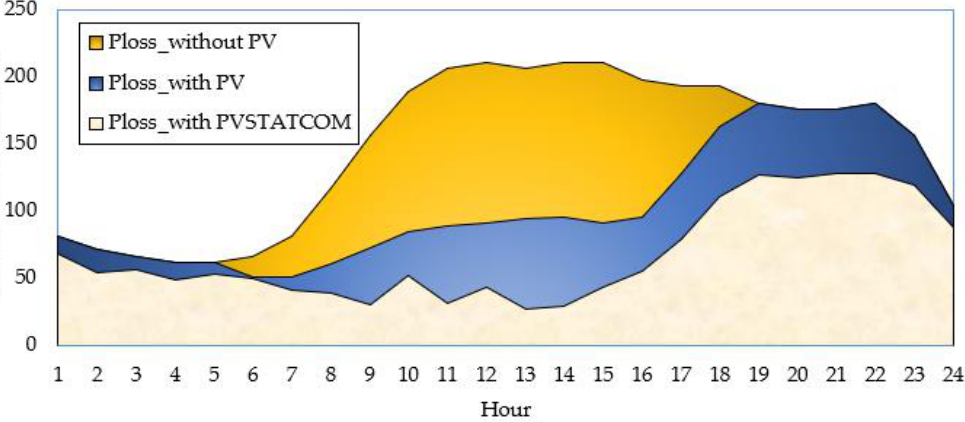
Figure 15. Hourly active power losses for the third scenario compared to the first and second scenarios for the IEEE 33-distribution system.